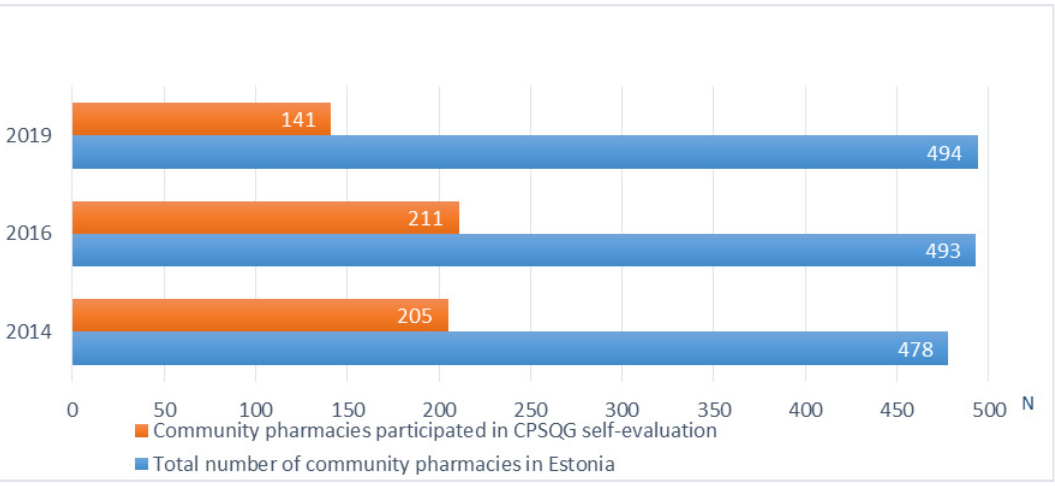
Figure 1. The number of community pharmacies participated in the self-assessment based on the Community Pharmacy Service Quality Guidelines in 2014-19 compared to all pharmacies operating in Estonia.